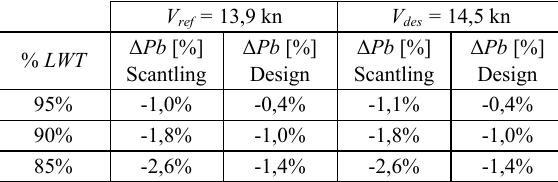
Table 7. Brake power reduction – bulk carrier 1